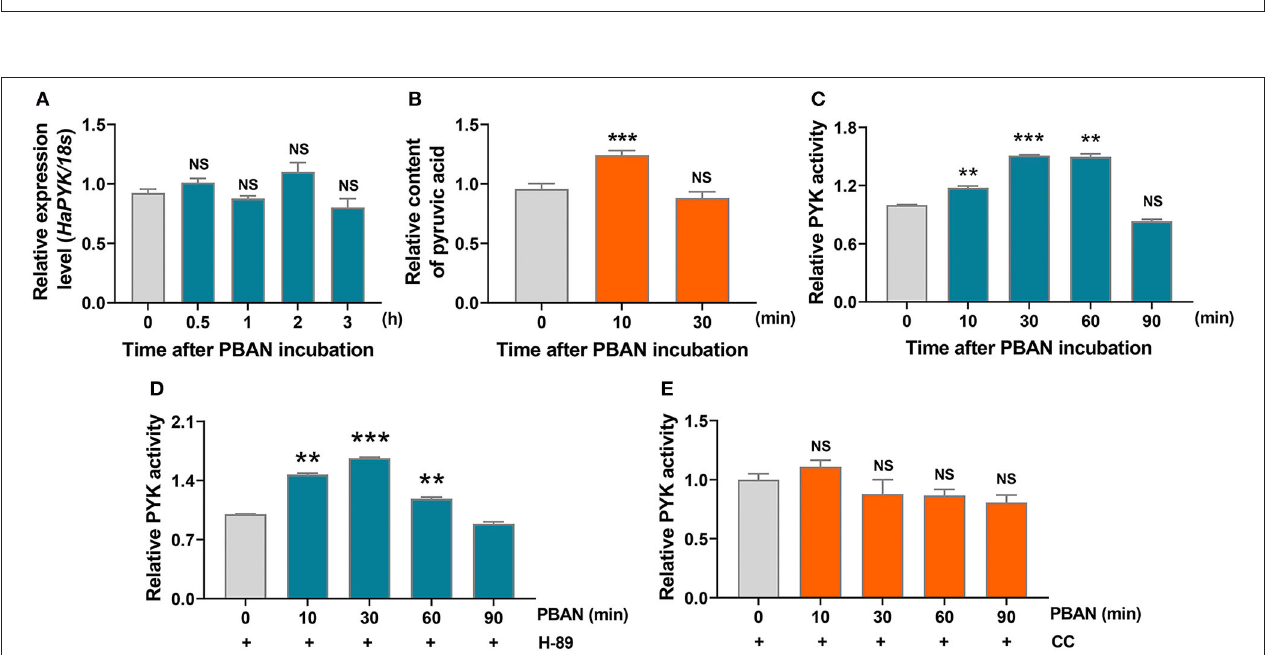
FIGURE 4 | PBAN regulated HaPYK activity through PKC. (A) The effect of PBAN treatment on the mRNA level expression of HaPYK . 18S was the internal reference. Error bars indicate the mean ± s.d. of three independent biological experiments. (B) The effect of PBAN treatment on the content of pyruvic acid. Error bars indicate the mean ± s.d. of three independent biological experiments, ***P < 0.001 (Student’s t -test). (C) The effect of PBAN treatment on HaPYK activity. Error bars indicated the mean ± s.d. of three independent biological experiments, ** P < 0.01, ** P < 0.001(Student’s t -test). (D) The effect of PKC inhibitor (CC) on HaPYK activity. Error bars indicate the mean ± s.d. of three independent biological experiments. (E) The effect of PKA inhibitor (H-89) on HaPYK activity. Error bars indicated the mean ± s.d. of three independent biological experiments, ** P < 0.01, *** P < 0.001(Student’s t -test).